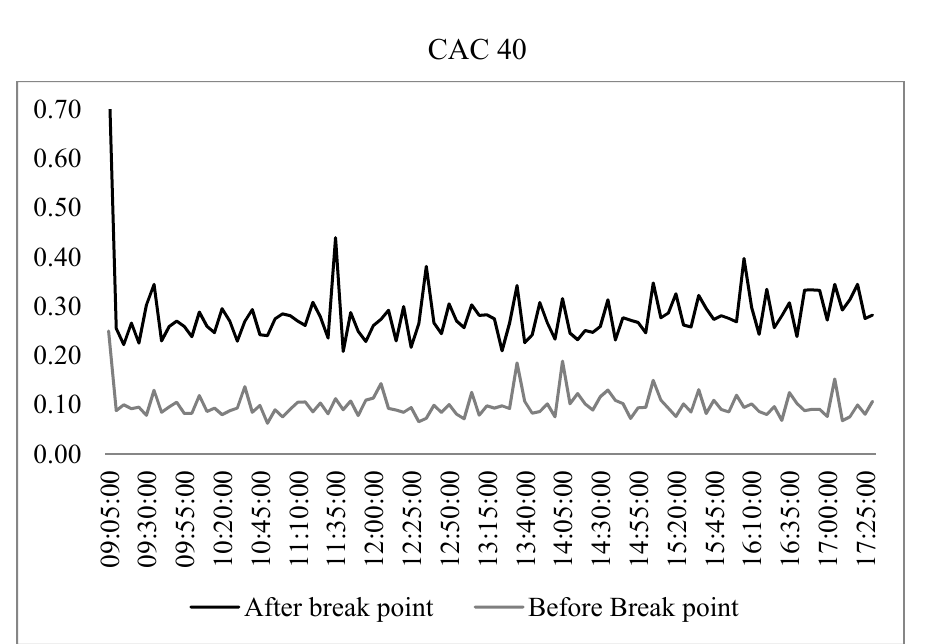
Figure 3. Average intraday volatility before and during the turmoil